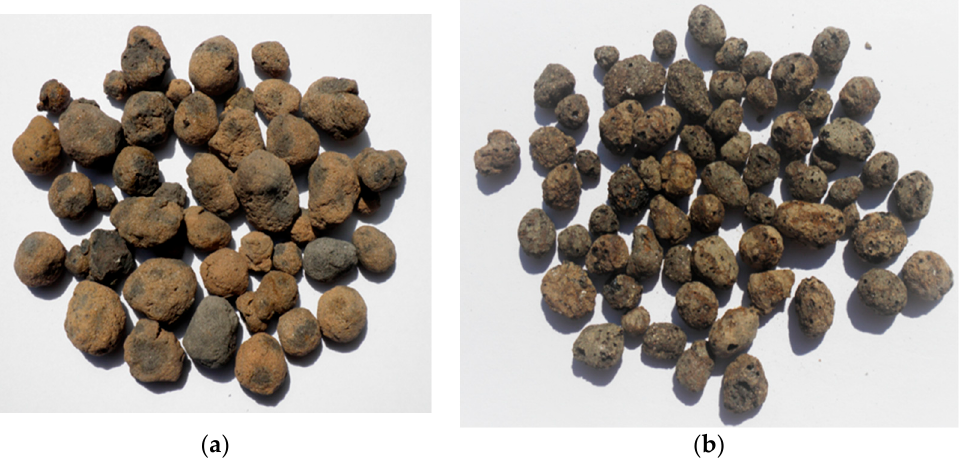
Figure1. Lightweightaggregatesusedforconcretetobetested: ( a )sinteredflyashand( b )expandedclay. Figure 1. Lightweight aggregates used for concrete to be tested: ( a ) sintered fly ash and ( b ) expanded clay. Table 1. Properties of coarse lightweight Table 1. Properties of coarse lightweight aggregates.